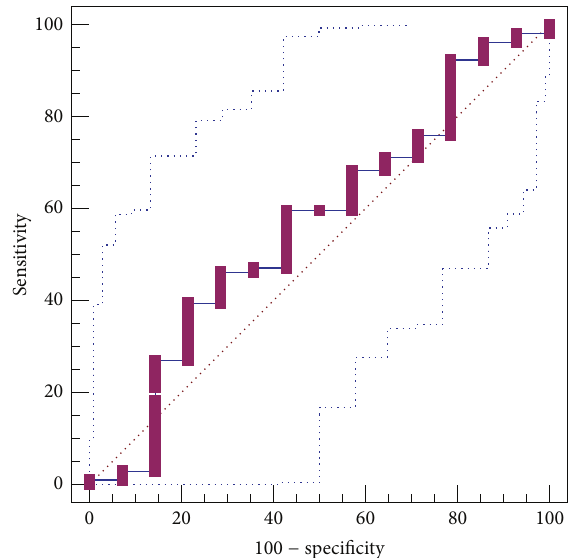
Figure4: ROCcurveanalysis toidentify thediscriminativecapacity of CIV level in predicting the presence of GEVs in liver